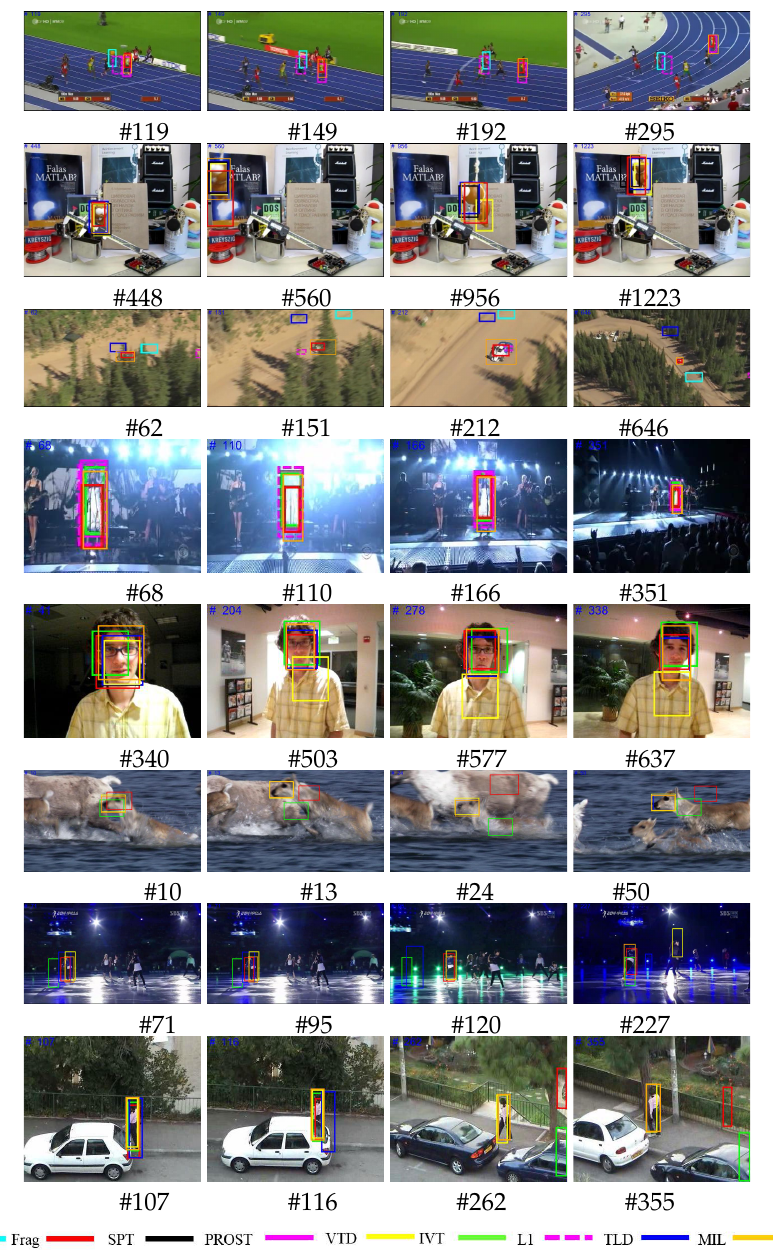
Figure 8. Tracking comparison for the proposed and current state of the art trackers for the Bolt, Lamming, Racecar and Singer image